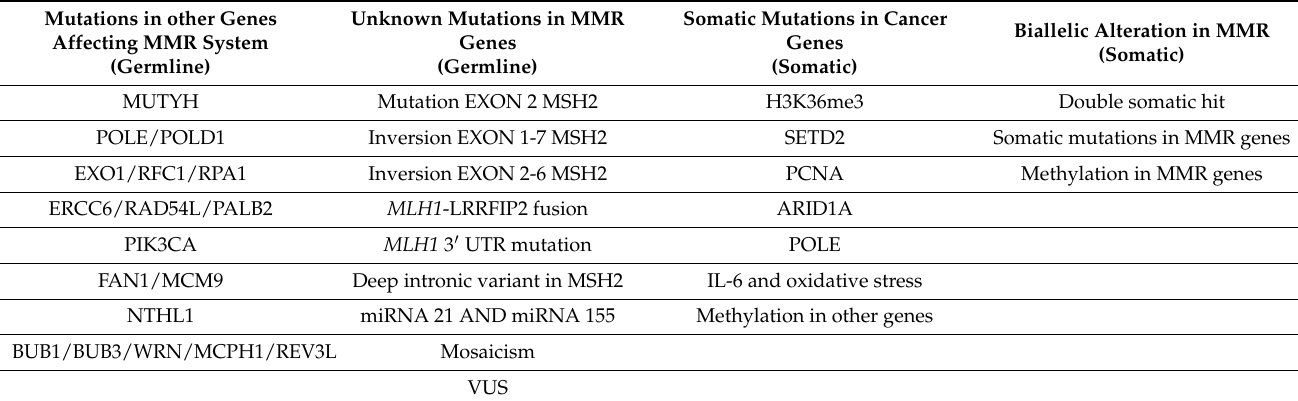
Table 1. Potential causes of LLS. LLS, Lynch-like syndrome; MMR, mismatch